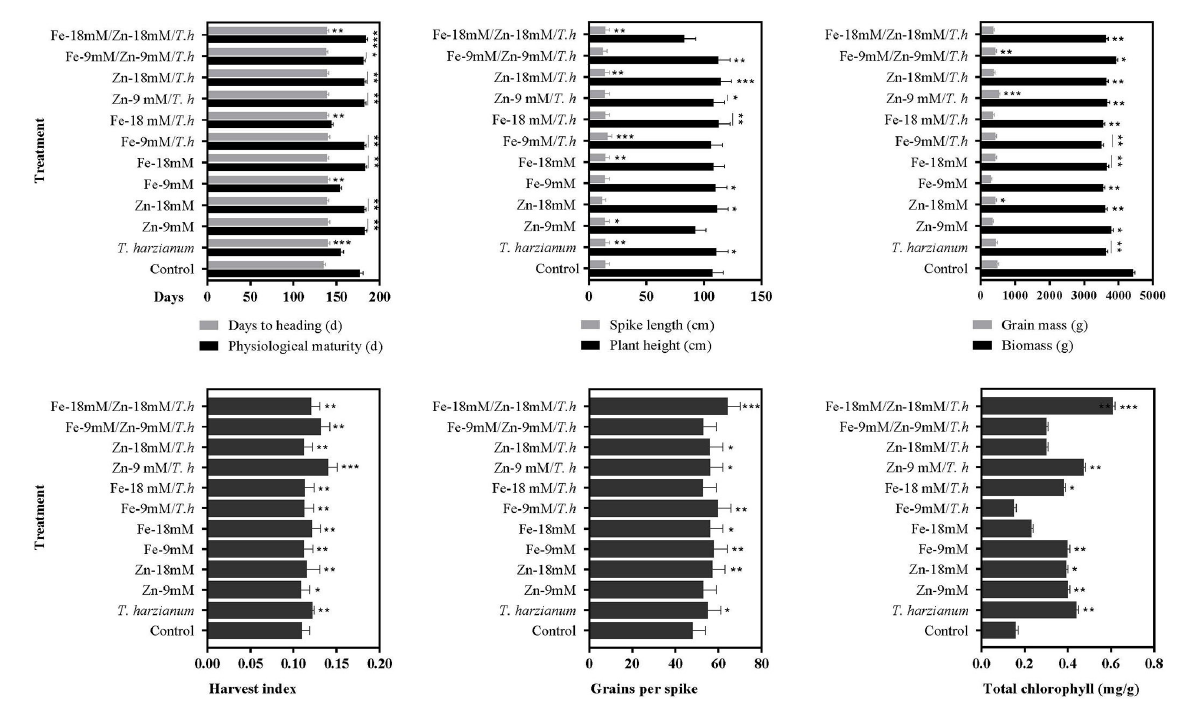
FIGURE1 Effects of Fe, Zn, and Trichoderma harzianum on the studied traits. Where: *, ** and *** are depicting statistical significances at 0.05, 0.01, and 0.001 probability level, respectively. While the bars without * are showing no statistically significant differences ( NS